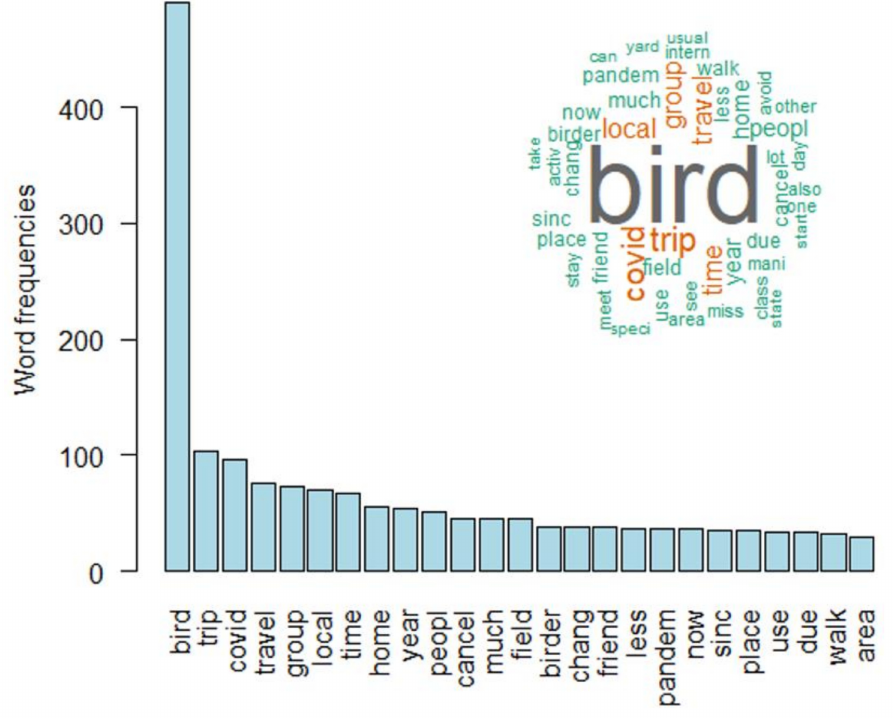
Figure 2. The bar plot illustrates the 25 most frequent words used in 2021 whereas the word cloud illustrates all words with a minimum frequency of